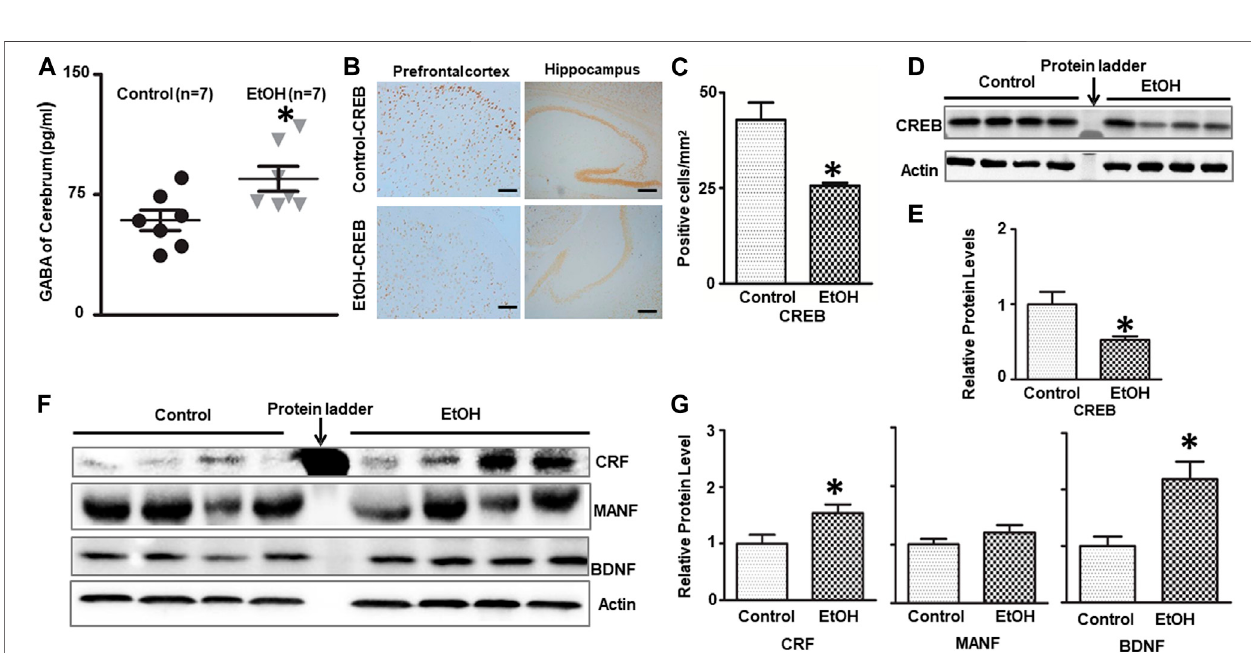
FIGURE 2 | Effects of chronic alcohol exposure on the levels of GABA and neurotrophic factors in the brain. (A) The concentration of GABA in the brain was determined by ELISA as described in the Materials and Methods . n (cid:2) 7, * p < 0.05 denotes a statistically signi fi cant difference from the control. (B) The expression of CREB in the cerebrum was determined by immunohistochemistry (IHC). (C) The numbers of CREB-positive cells in the hippocampus or prefrontal cortex (PFC) were determined.Theresultswereexpressedasthemean ± SEM;n (cid:2) 4,* p < 0.05denotesastatisticallysigni fi cantdifferencefromthecontrolgroup. (D) Theexpression ofCREBwasdeterminedbyimmunoblotting(IB). (E) TherelativeamountsofCREBwerequanti fi edandnormalizedtotheexpressionofactin. (F) TheexpressionofCRF, BDNF and MANF in the cerebrum was determined by IB. (G) The relative amounts of CRF, BDNF and MANF were quanti fi ed and normalized to the expression of actin. The results were expressed as the mean ± SEM, n (cid:2) 4 for each group. * p < 0.05 denotes a statistically signi fi cant difference from the control group.